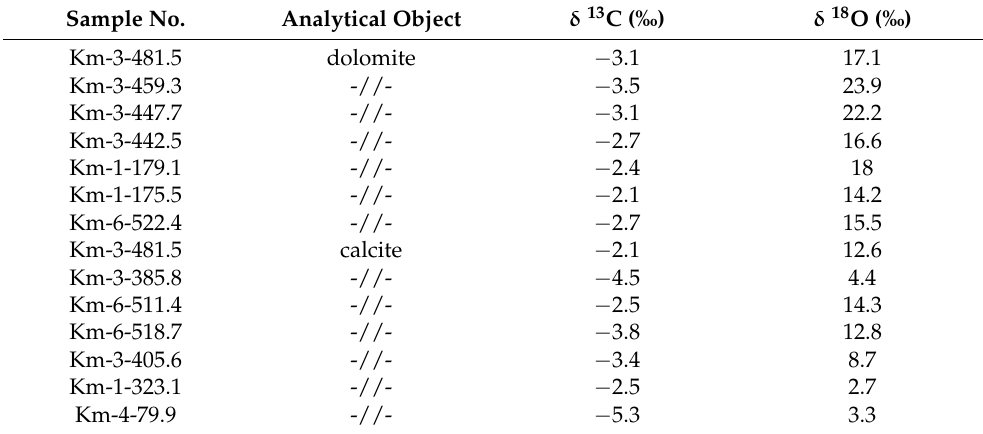
Table 2. Isotopic composition of carbon and oxygen from the Kultuma deposit. Sample